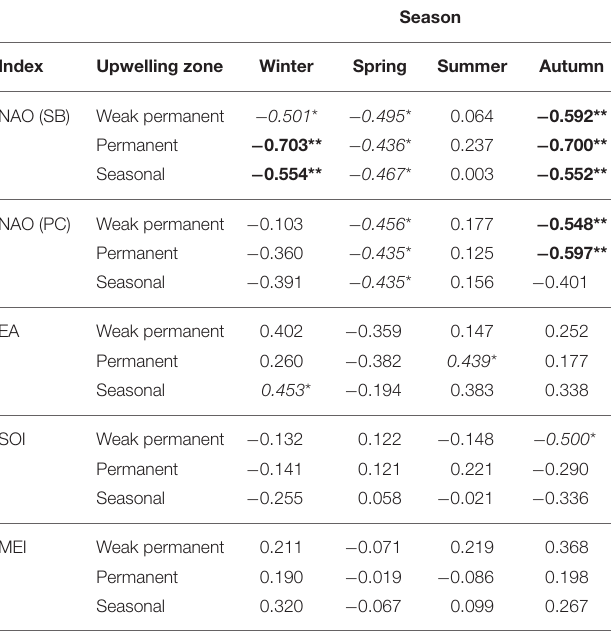
TABLE 2 | Correlations between seasonal SST anomalies and selected climate indices with no lag applied for the 1993–2014